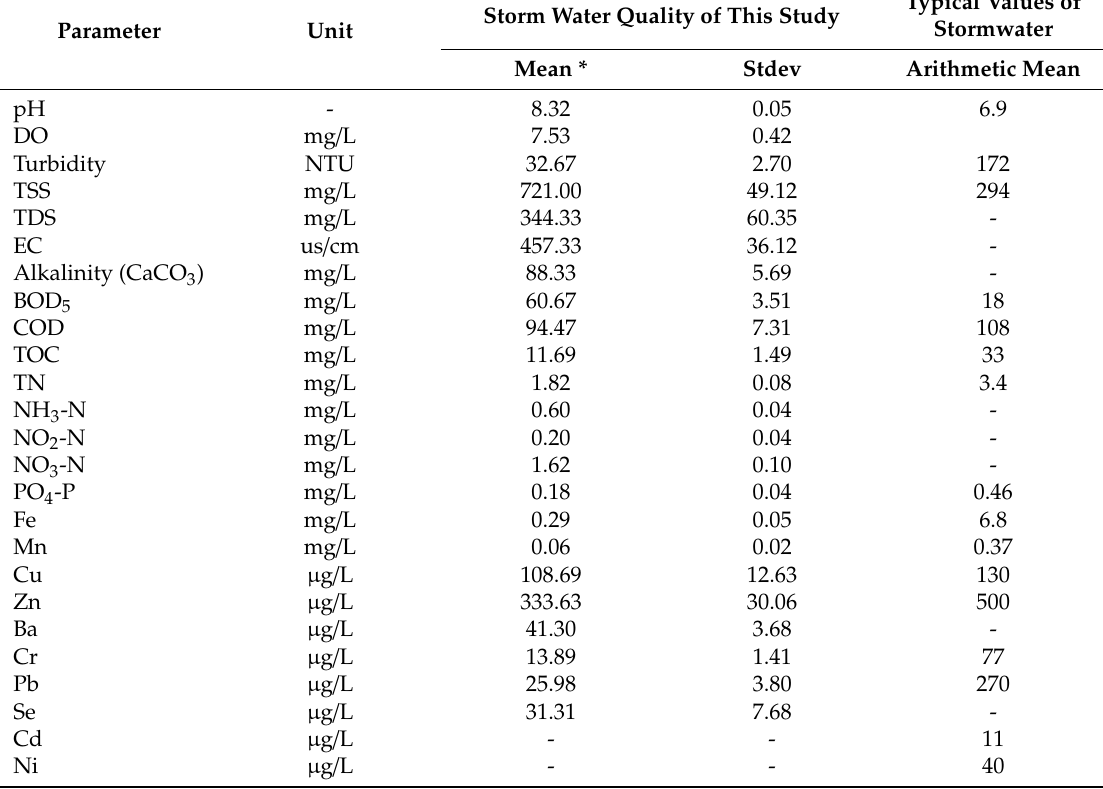
Table 2. Physico-chemical quality of stormwater collected from QU campus pond and typical values of